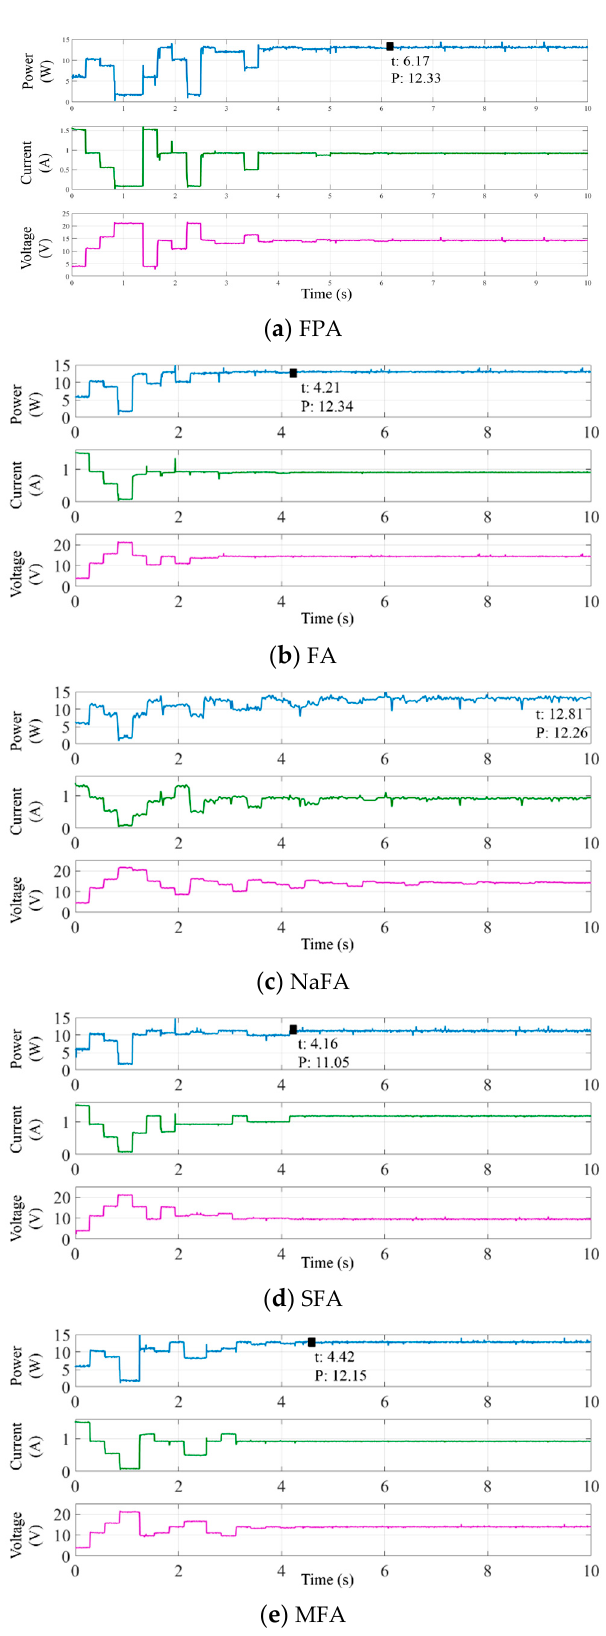
Figure 19. Power, current, and voltage variations during one evaluation tracking process of the five algorithms under Pattern #9.